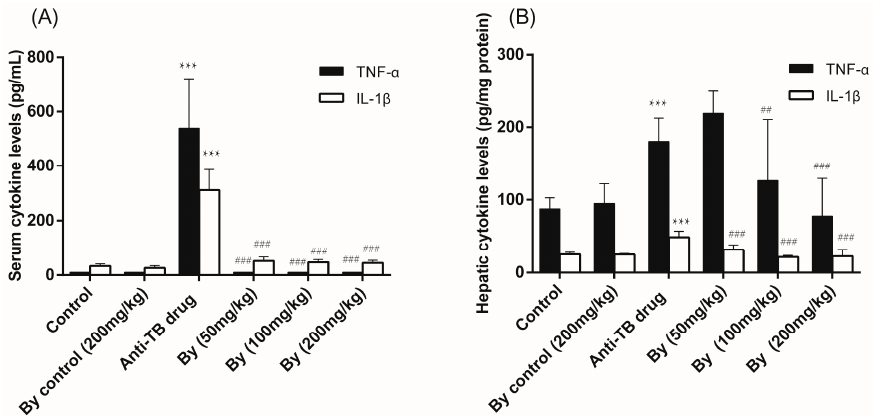
Figure 4. Effects of bicyclol on serum ( A ) and hepatic ( B ) TNF- α and IL-1 β protein expression in anti-TB drug intoxicated rats. Bicyclol (50, 100, 200 mg/kg) was administered orally to rats for 30 days. Data were expressed as means ± SD ( n = 10). ***, p < 0.001 vs. control group; ## , p < 0.01, ### , p < 0.001 vs. anti-TB drug intoxicated group.